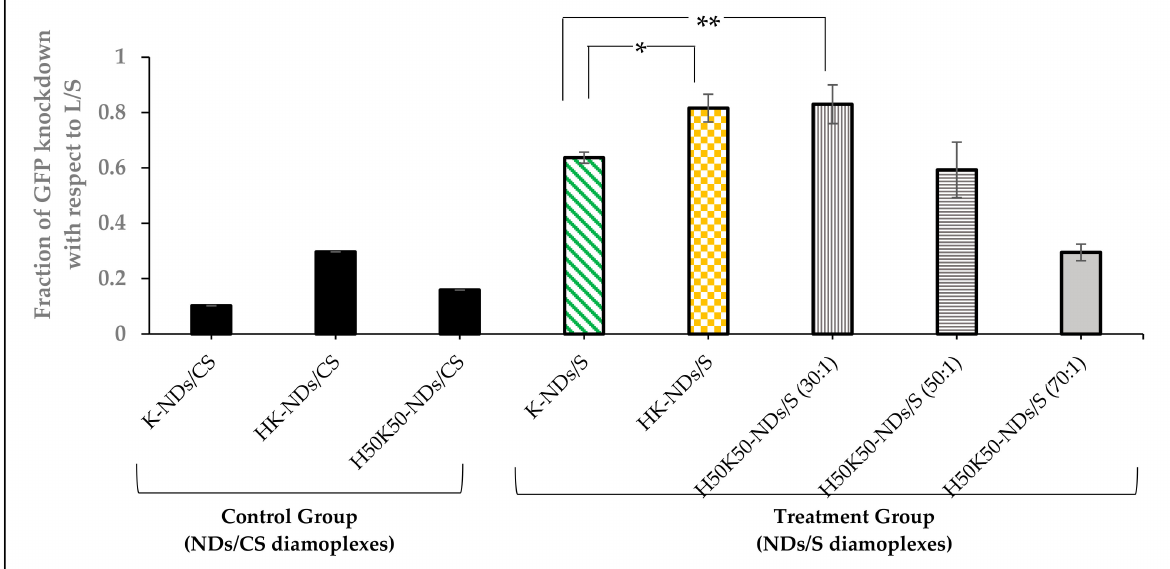
Figure 8. Fraction of GFP knockdown induced by diamoplexes of K-NDs, HK-NDs and H 50 K 50 - NDs with anti-GFP siRNA or scrambled siRNA with respect to lipofectamine RNAimax-based lipoplexes 48 h post-exposure. Fraction of GFP knockdown closer to 1 is representative of better siRNA transfection by diamoplexes. Statistical tests: one-way ANOVA; p -value < 0.001 and Tukey’s post hoc analysis showing that difference in mean is statistically significant between * K-NDs/S vs. HK-NDs/S ( p -value = 0.019) and ** K-NDs/S vs. H 50 K 50 -NDs at 30:1 ( p -value = 0.021) and not statistically significant between HK-NDs vs. H 50 K 50 -NDs at 30:1 and K-NDs vs. H 50 K 50 -NDs at 50:1 value. (NDs/CS = diamoplexes of functionalized NDs with scrambled siRNA used as the negative control; NDs/S- diamoplexes of functionalized NDs with anti-GFP siRNA; L/S = lipofectamine-based lipoplexes containing anti-GFP siRNA; K-NDs = lysine functionalized NDs; HK-NDs = lysyl-histidine functionalized NDs and H50K50-NDs = lysine/lysyl-histidine functionalized